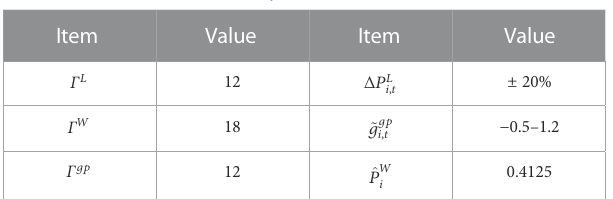
TABLE 6 Parameters of